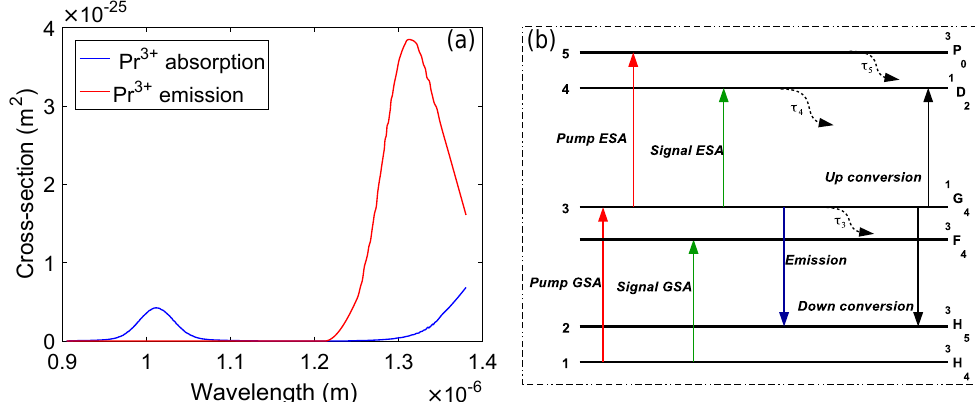
Figure 1. ( a ) Pr 3 + absorption and emission spectra. ( b ) Energy level